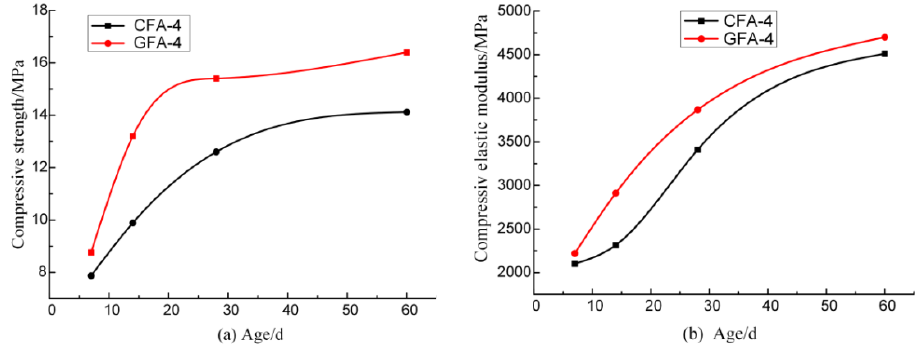
Figure 1. Mechanical properties change with age. ( a ) Compressive strength. ( b ) Compressive elastic modulus.